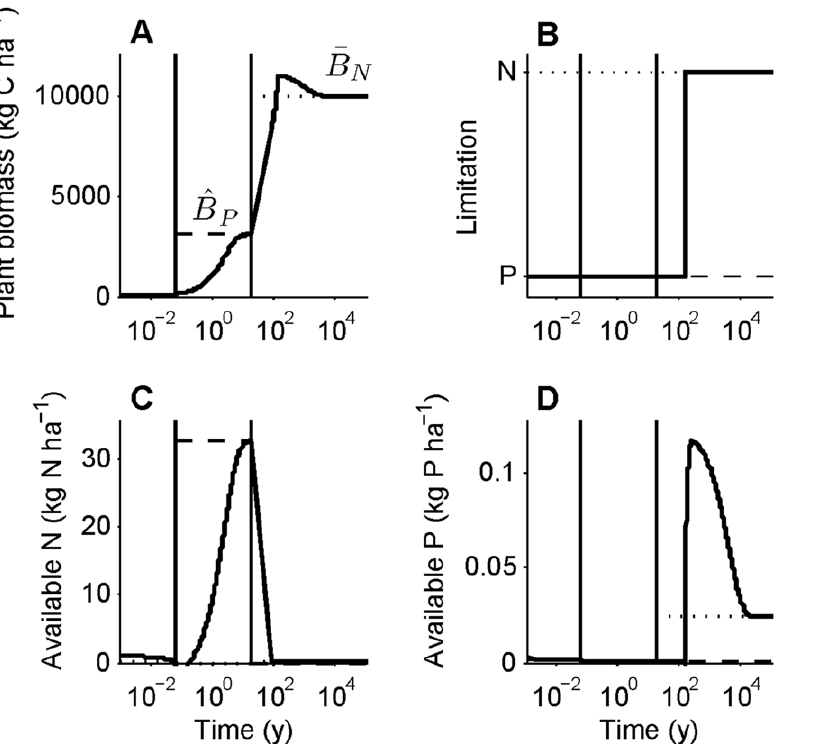
Figure 4. Timescale approximation illustrating the effects of obligate N fixation and high continual P inputs. Parameters and starting conditions are as in Fig. 2 except that F =0.07 kg N kg C 2 1 y 2 1 for the short and intermediate timescales and a =0.2 kg P ha 2 1 y 2 1 throughout. At the end of the intermediate timescale F is set to 0 to simulate the exclusion of N fixers. (A) Plant biomass, (B) which nutrient limits net primary production (NPP), (C) plant-available N, and (D) plant-available P are shown. Breaks in timescales, quasi equilibria, and equilibria are shown as in Fig. 2. In this case obligate N fixers fix enough to overcome N limitation, hence P limits NPP through the short and intermediate timescales. Although P weathering depletes rock P as in Fig. 2, relatively high dust deposition and high losses of plant-unavailable N relative to P combine to make N limit NPP at the terminal steady state.